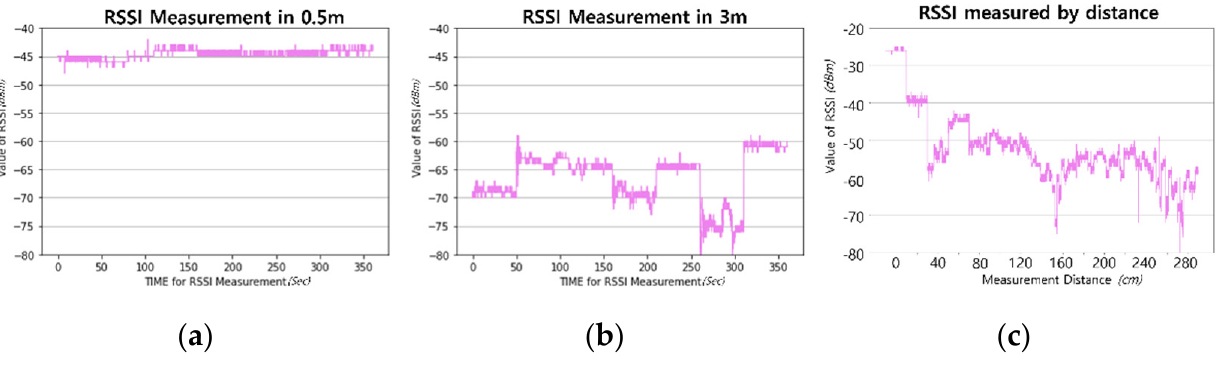
Figure 3. RSSI variations by practical measurement: from leftmost, ( a ) short distance, ( b ) long distance, and ( c ) various distances.